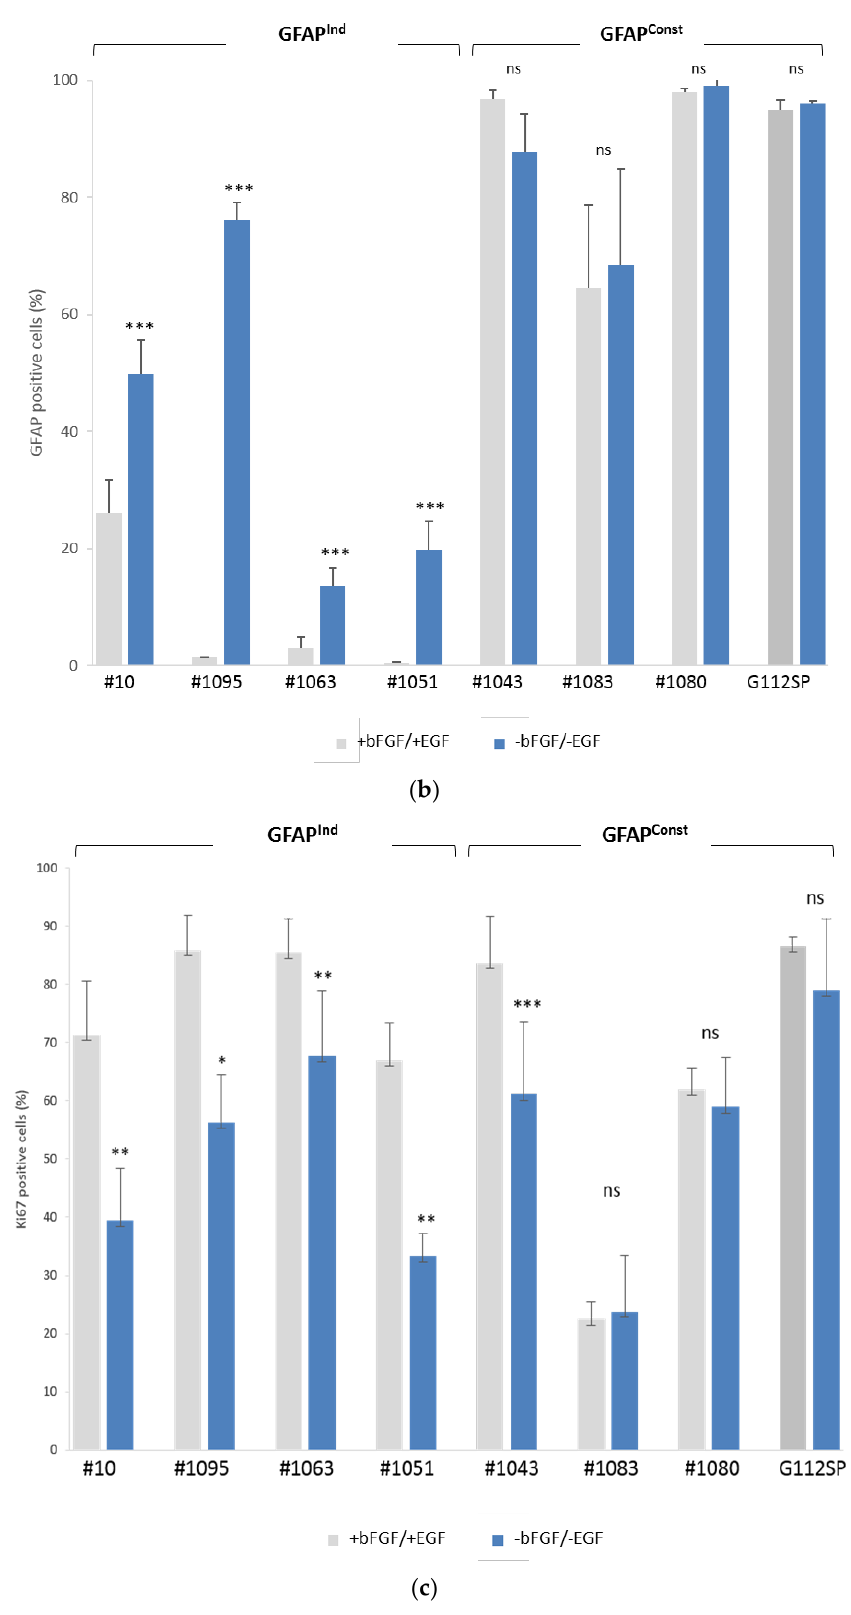
Figure 1. Assessments of GFAP expression and proliferation in different glioma stem cell (GSC) lines. ( a ) Immunocytochemical staining for GFAP (red) and nestin (green) in GSC line #1095 under self-renewal promoting (+bFGF/+EGF) or differentiation-inducing (-bFGF/-EGF) condition. Nuclear counterstaining by DAPI (4',6-Diamidino-2-Phenylindole, Dihydrochloride). Antibody control panels